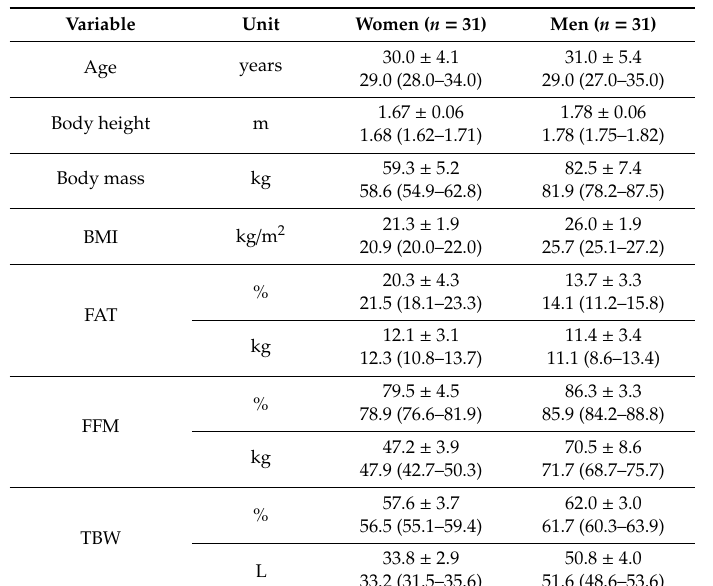
Table 1. Anthropometric characteristics of studied CrossFit-trained